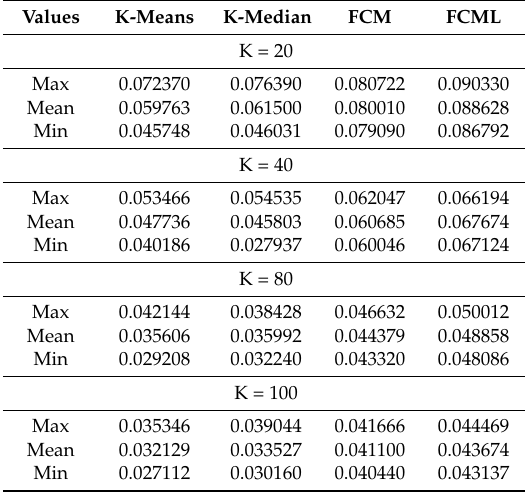
Table 2. The maximum (Max), mean, and minimum (Min) values of the PBM-index obtained by the K-means, K-median, and FCML for 20 different runs for four real-world taxi GPS datasets. Values